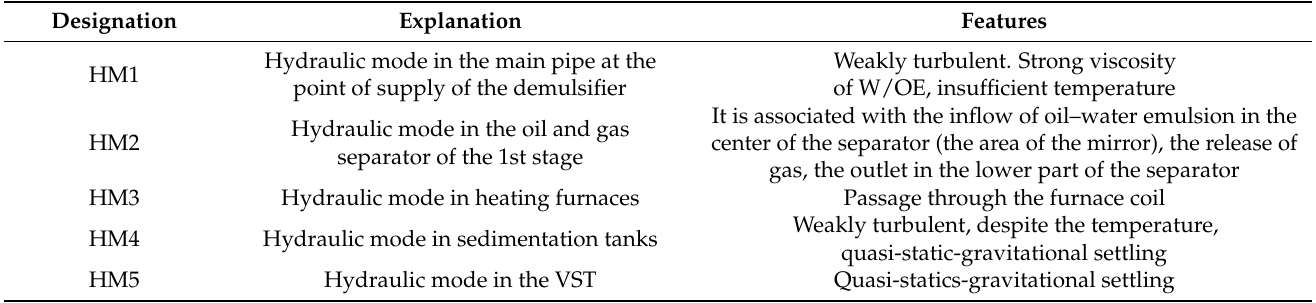
Table 2. Hydrodynamic modes of mixing of water-in-oil emulsion isolated during the